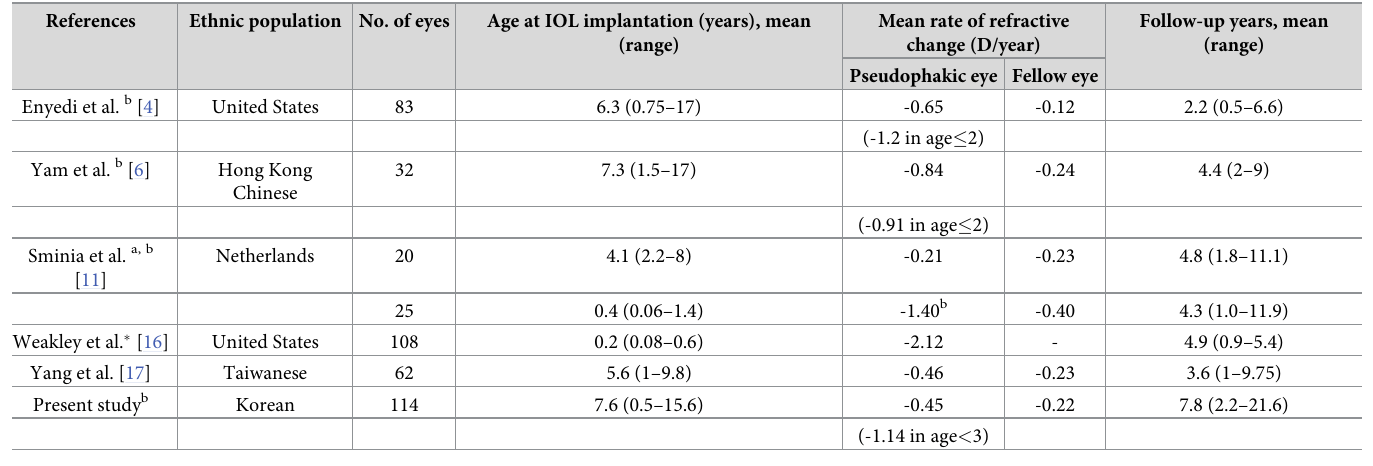
Table 5. Previous studies on refractive changes after unilateral pediatric cataract